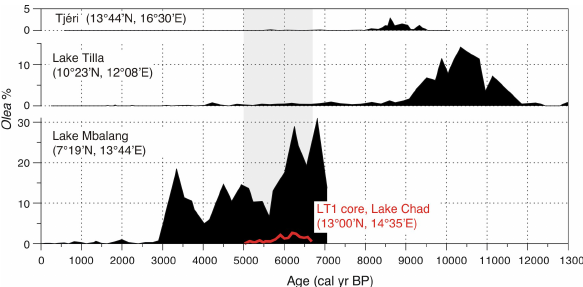
Fig. 11. Comparison between Olea frequencies from Tj´eri (Maley, 1981), Lake Tilla (Salzmann et al, 2002), Lake Mbalang (Vincens et al., 2010) and Lake Chad (this work). The grey band represents the time interval covered by LT1